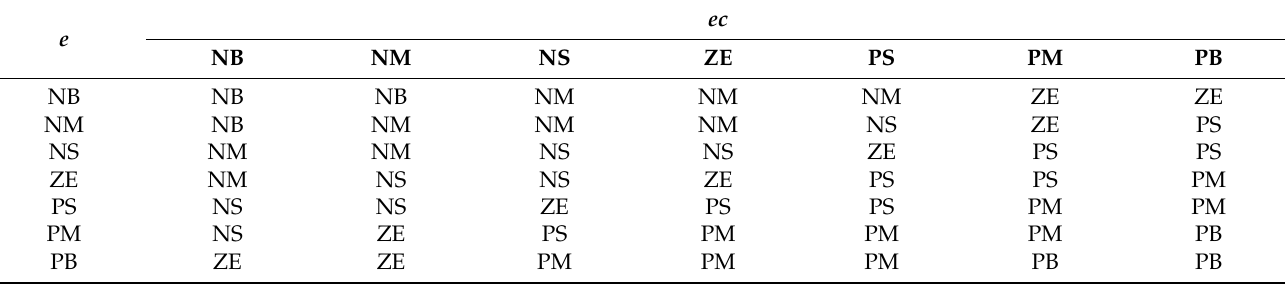
Table 7. Setting rules of ∆ K P